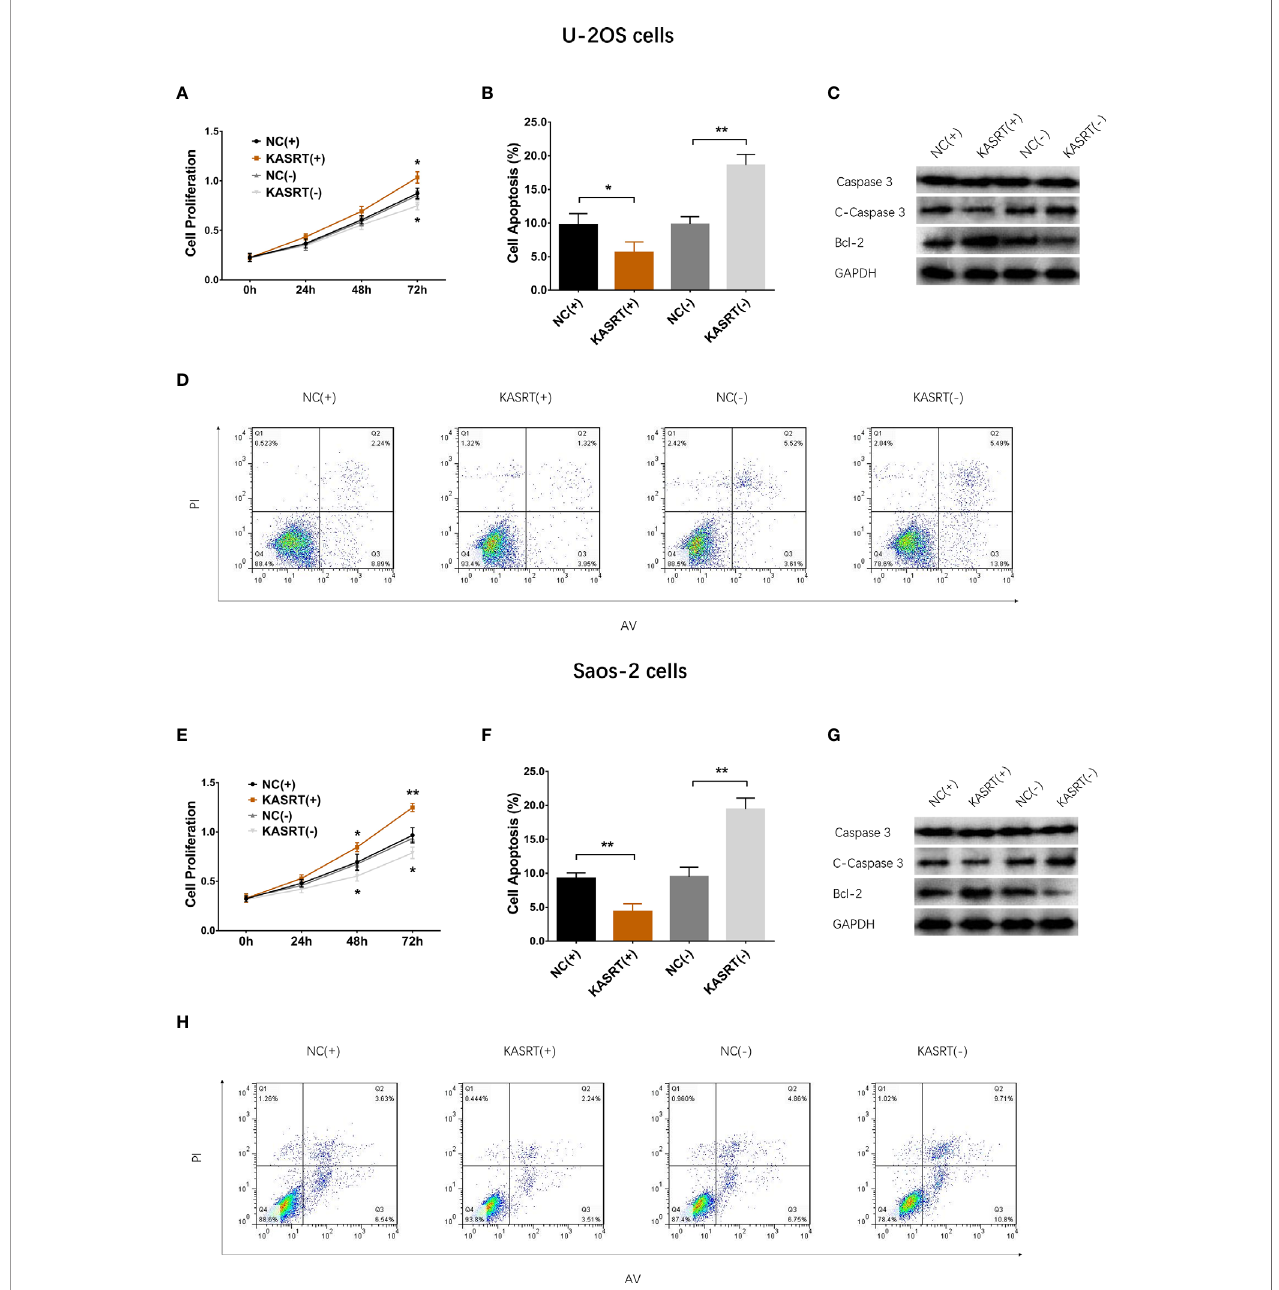
FIGURE 2 | Cell proliferation and apoptosis. Cell proliferation (A) , cell apoptosis rate (B) , pro-/anti-apoptotic marker expression (C) , and AV/PI images (D) among the groups of U-2OS cells. Cell proliferation (E) , cell apoptosis rate (F) , pro-/anti-apoptotic marker expression (G) , and AV/PI images (H) among the groups of Saos-2 cells. *P < 0.05, **P <